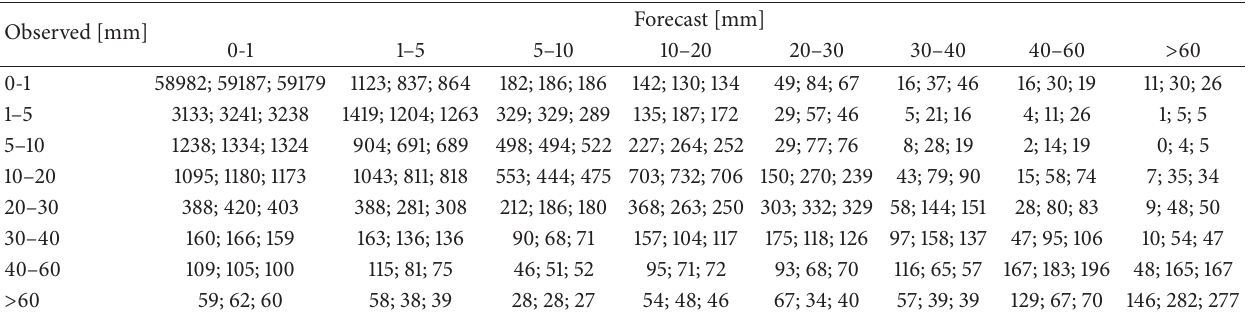
Table 4: Multicategory contingency table for different precipitation intervals for R 6, RW5, and RW6. In each cell, the first number gives the occurrences of R 6, the second number the occurrences of RW5, and the third number the occurrences of RW6. Observation intervals are in the rows, while forecast intervals are in the